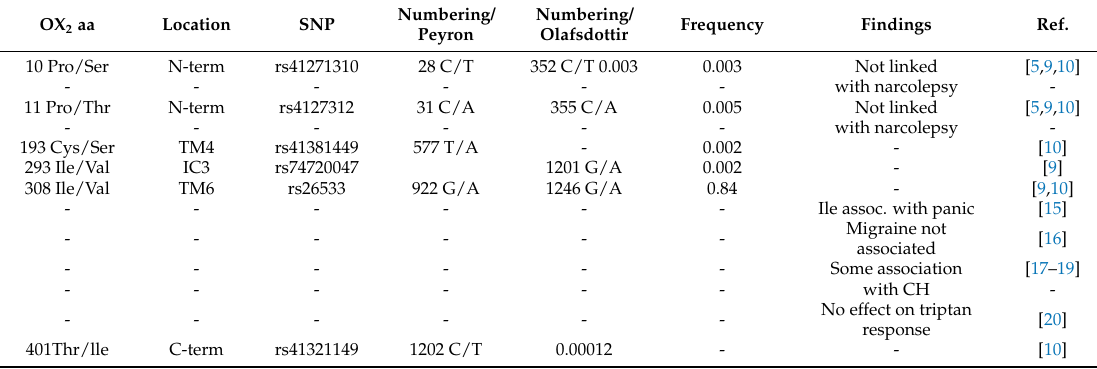
Table 2. OX 2 orexin receptor variants investigated in disease. aa, amino acid; IC, intracellular